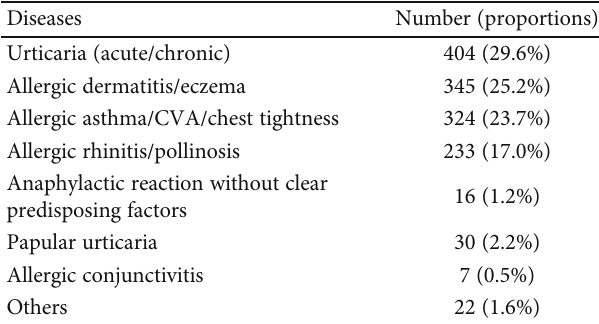
Table 1: Number and percentage of allergic diseases among 1367